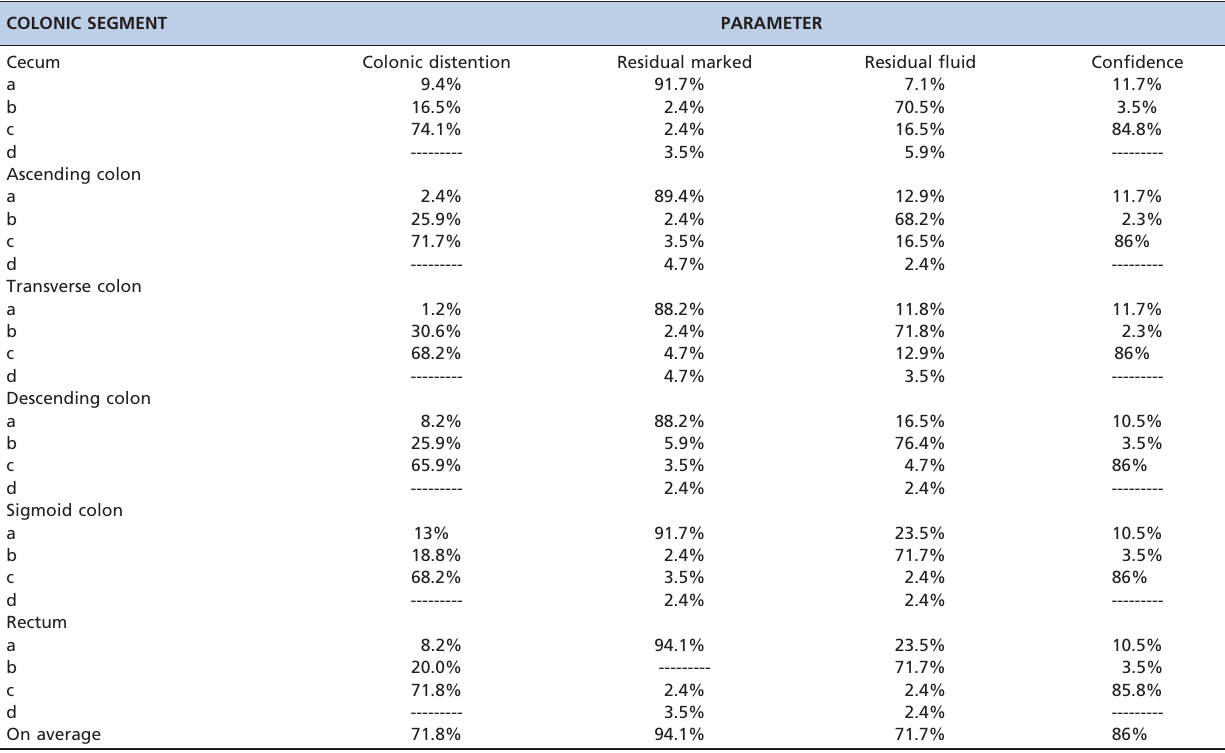
Table 3 - Quality percentages calculated in preparation and confidence in the diagnostic evaluation of each colonic